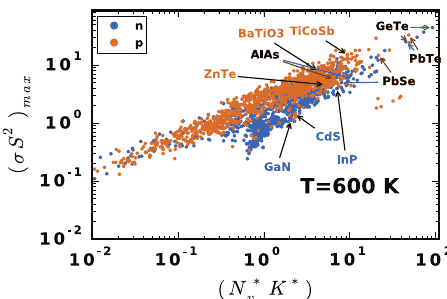
Fig. 3 Maximum power factor for ~ 2300 cubic compounds plotted as a function of the Fermi surface complexity factor (evalulated at the Fermi level which yields the maximum power factor) at T = 600